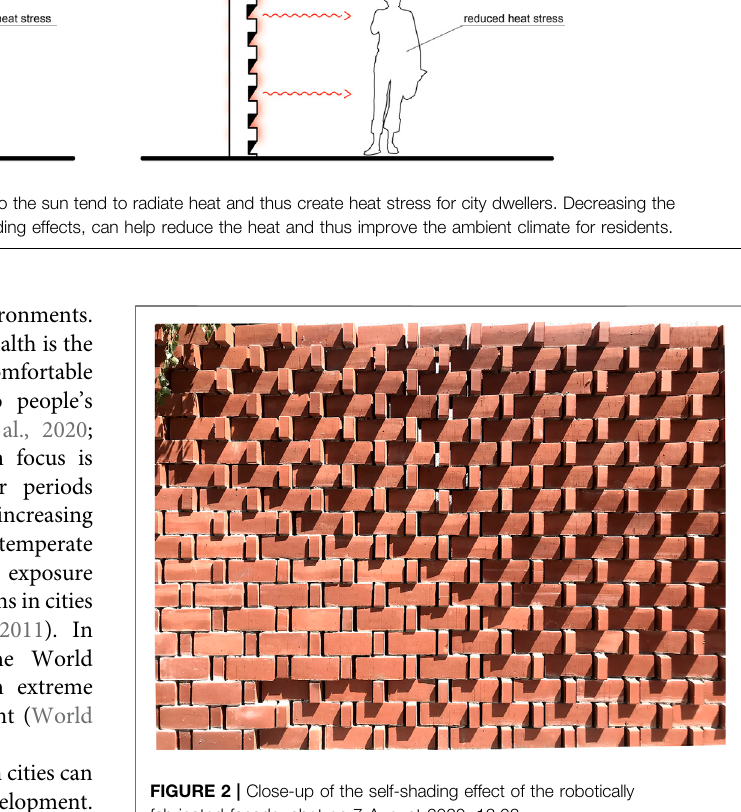
Frontiers in Built Environment |